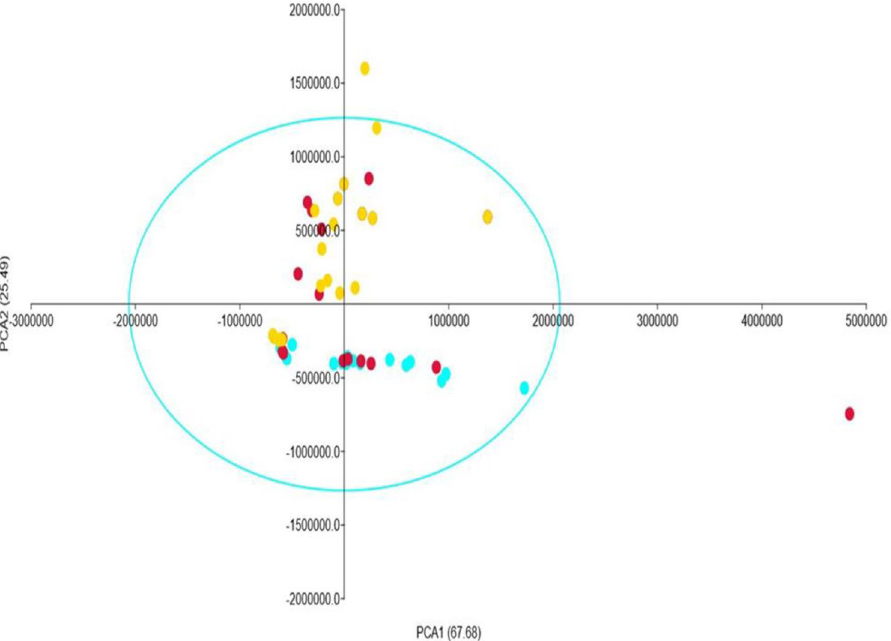
Figure 10. Principal component analysis of primary metabolites profile of African horned cucumber fruit harvested from different treatments. The explained variables are shown in different colours (Blue = Greenhouse, Red = shade net, and Yellow = open field).